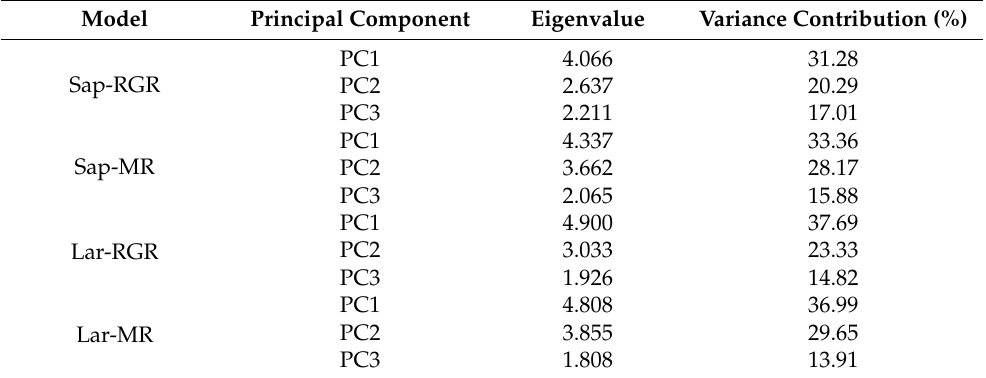
Table 3. Eigenvalues of topographical and soil-based factors and their contributions in the typical mixed broadleaved Korean pine